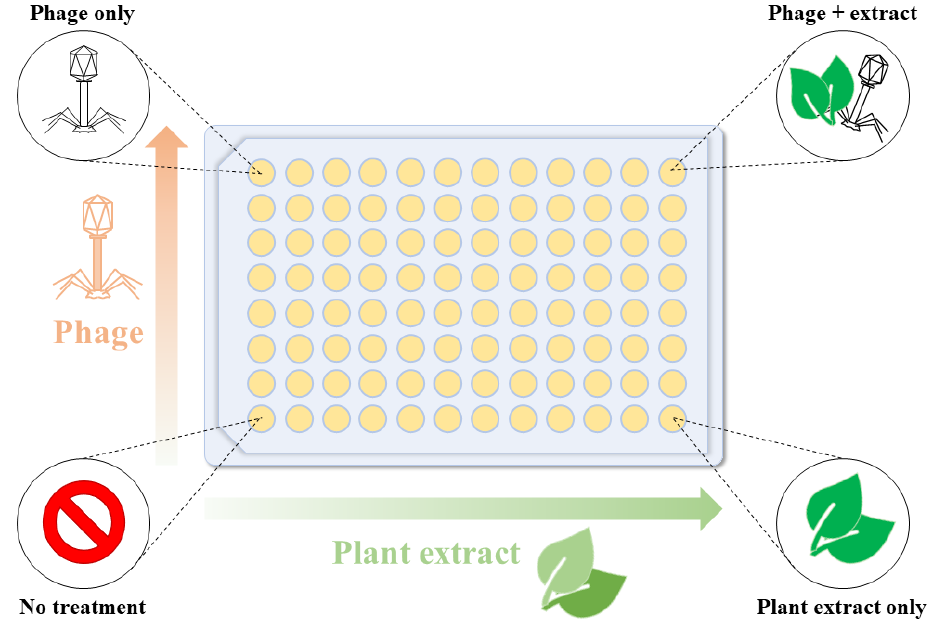
Figure 1. Synogram showing the distribution of phage–extract combinations against the bacterial inoculum.